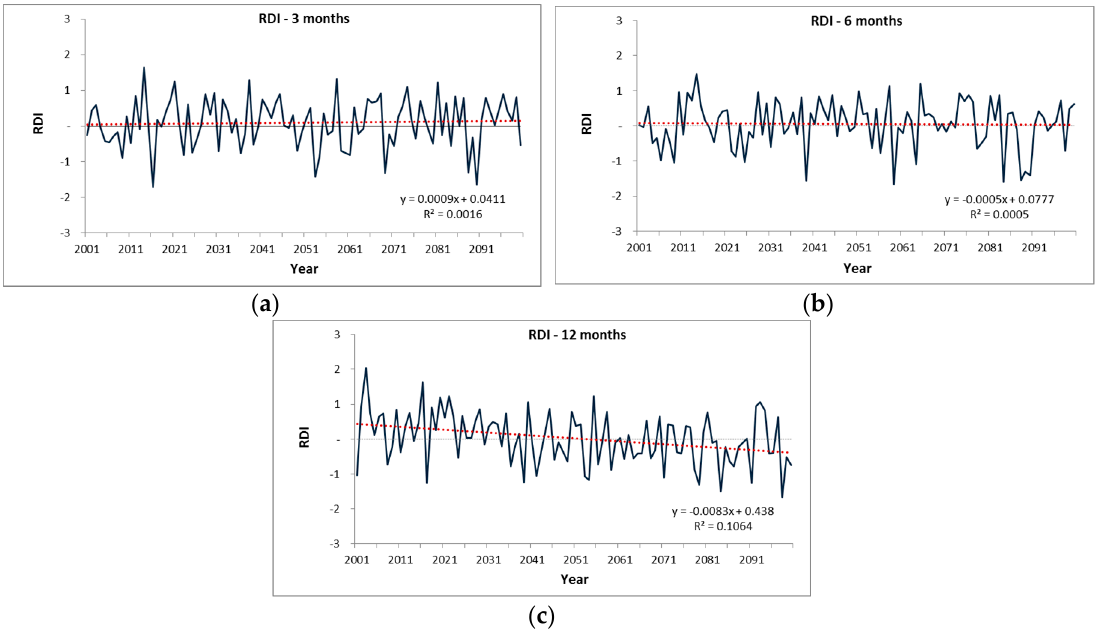
Figure 5. RDI estimation results for three selected periods in Korea: ( a ) Period of 3 months; ( b ) Period of 6 months; ( c ) Period of 12 months.